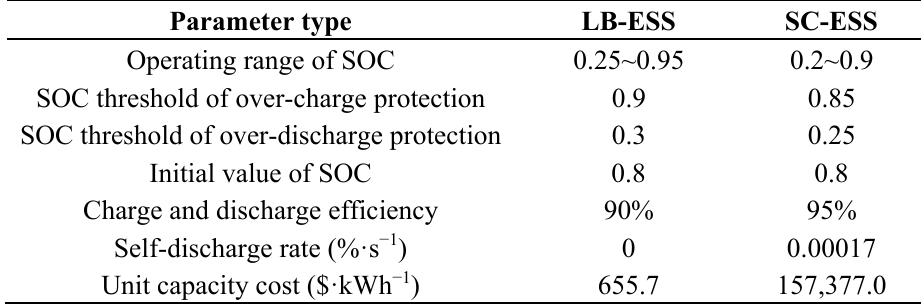
Table 1. Main parameters setting of two